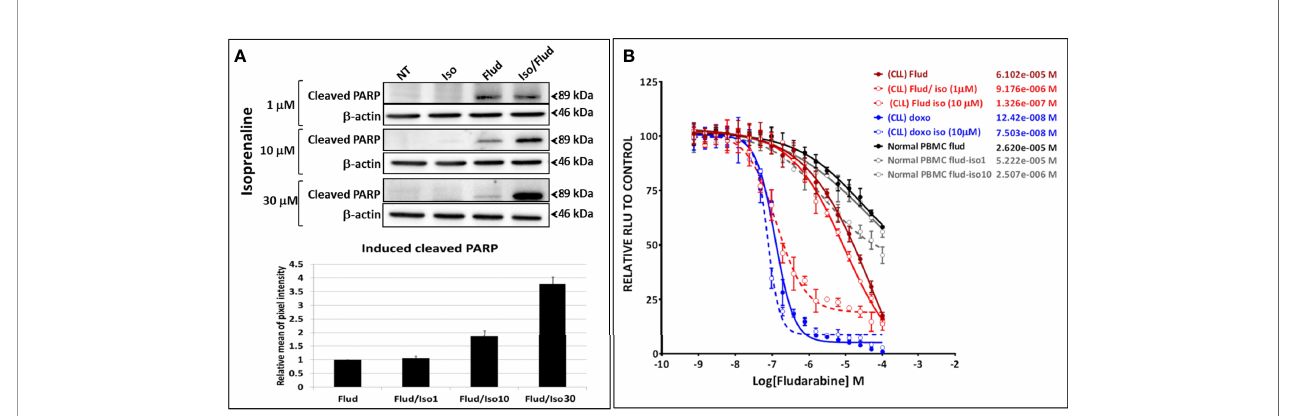
FIGURE 6 | Isoprenaline synergizes speci fi cally with the purine analogue fl udarabine in dose-dependent manner. (A) The cytotoxic effect of fl udarabine (10 m M) combined with an increasing concentration of Isoprenaline (1, 10, 30 m M) was assessed through the quanti fi cation of the apoptotic marker (cleaved PARP). Full-length blots/gels are presented in Supplementary Figure 9 . (B) CPCs were treated with a gradient of fl udarabine (red plots) or Doxorubicin (blue plots) concentrations combined with either 1 m M or 10 m M Isoprenaline. The cytotoxic effect of Fludarabine/Isoprenaline combination was also assessed in PBMC isolated from normal donors (gray scale plots).